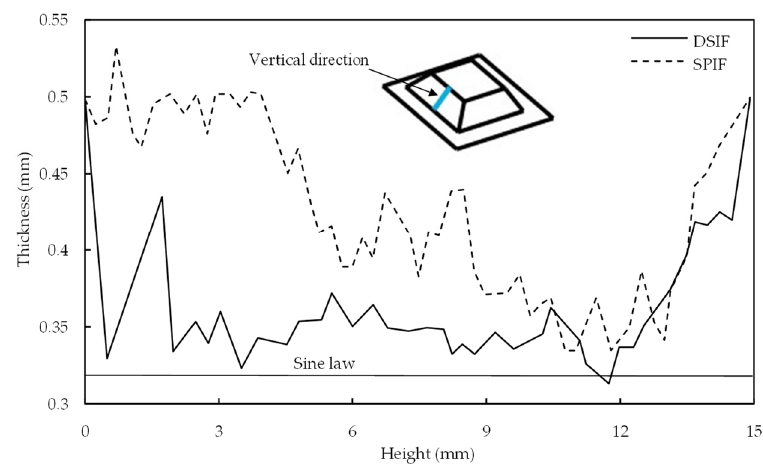
Figure 5. Distributions of sheet thickness in the vertical direction (reprinted with permission from Otsu et al. [29], Copyright 2018 Elsevier).